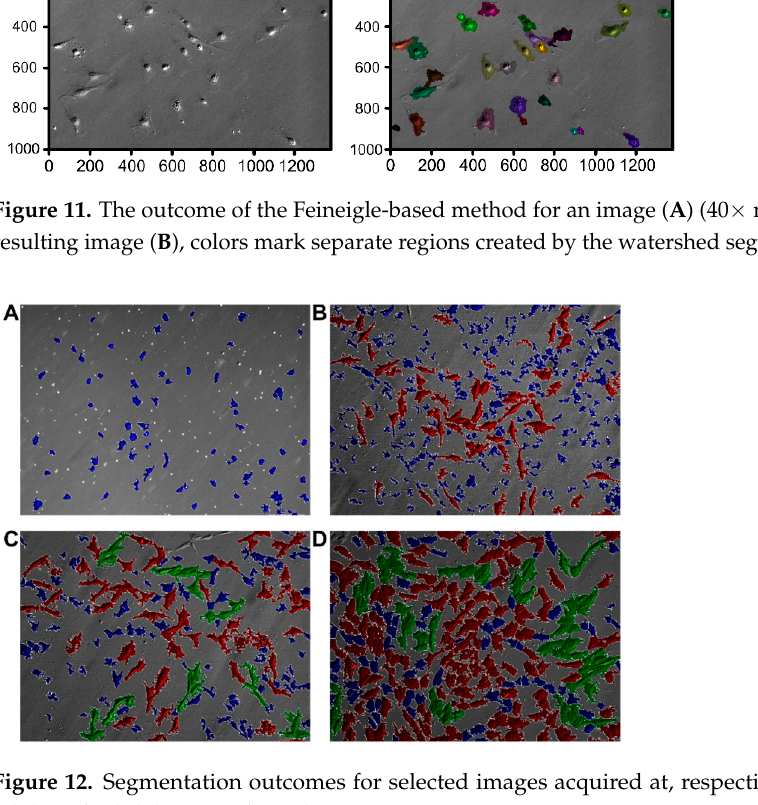
Figure 12. Segmentation outcomes for selected images acquired at, respectively, day 1 ( A ), 2 ( B ), 4 ( C ), and 7 ( D ) (10× resolution).